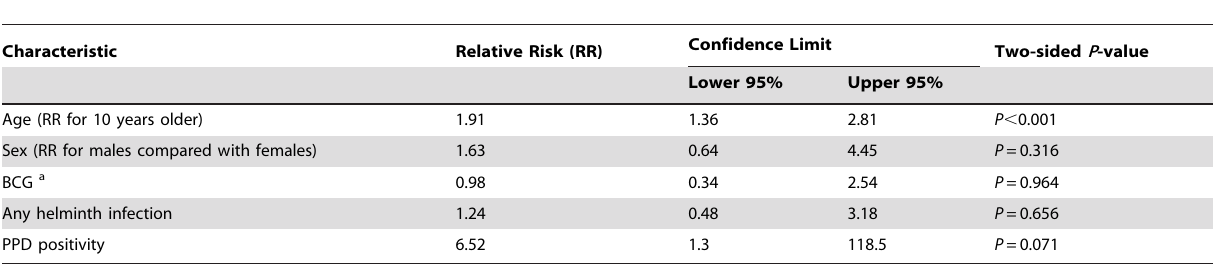
Table 3. Results Using the Generalized Linear Model for Baseline Data.